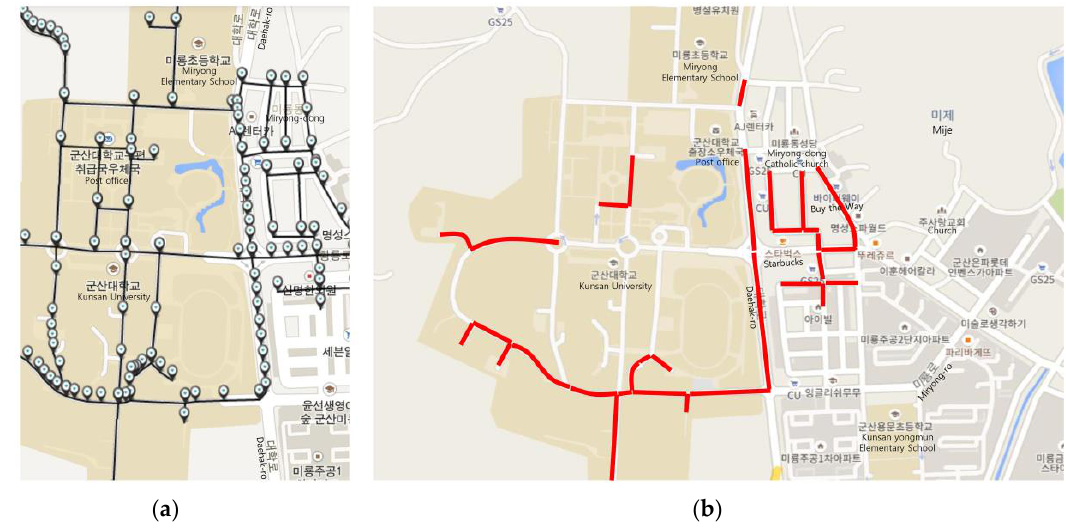
Figure 10. Snapshot of implementation: ( a ) Intersection points and path segments; ( b ) example of service disabled path segment.